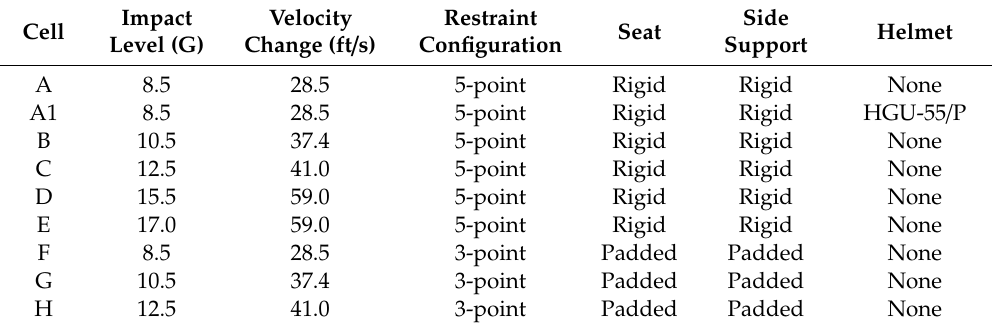
Table 1. Horizontal Impulse Accelerator (HIA) test matrix for the lateral impact study.